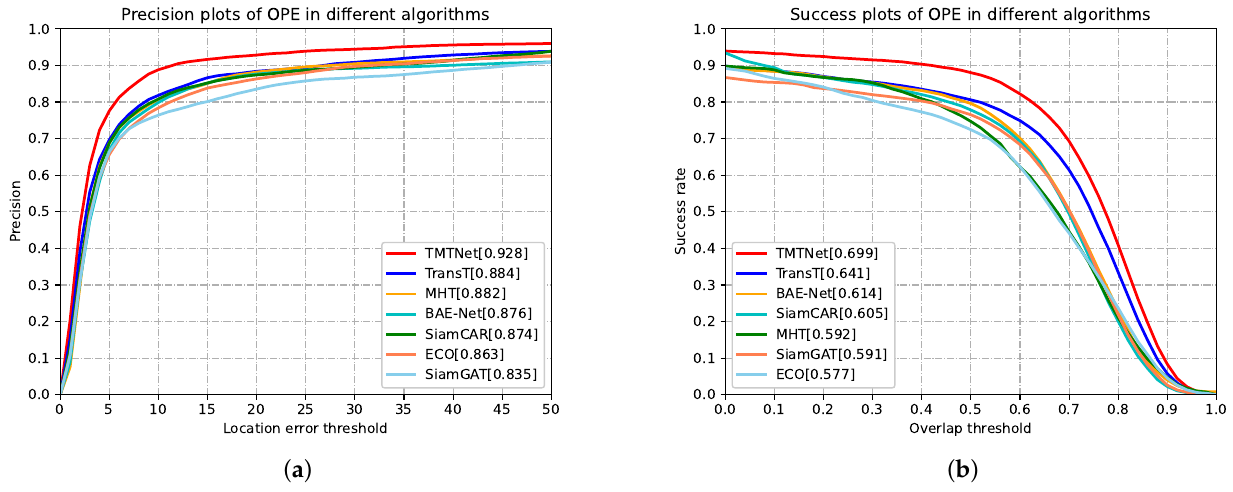
Figure 10. Comparison of success plot and precision plot of tracking results. ( a ) Overall precision plot; ( b ) Overall success